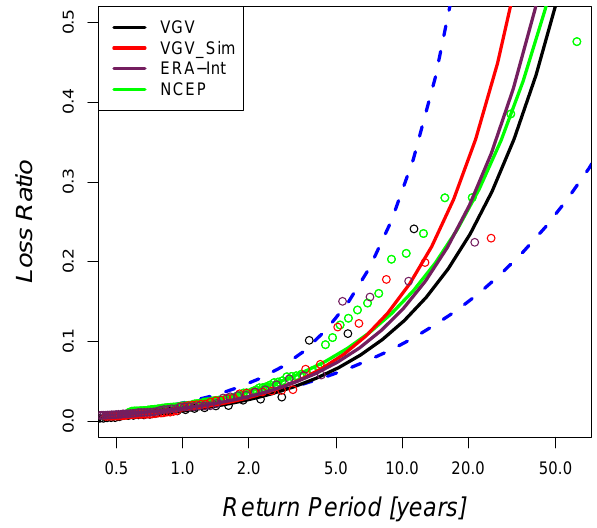
Fig. 7. Return period (unit: years) vs. return level (loss ratio, unit: ‰) plot for loss ratios based on the different loss datasets: VGV (black), VGV Sim (red), losses calculated based on ERA-Interim gust (purple) and NCEP (green). Points indicate the empirical dis- tribution, the solid lines the GPD best fits, the blue dashed lines the 95% confidence interval (Profile Log-Likelihood Method) for the fit based on NCEP